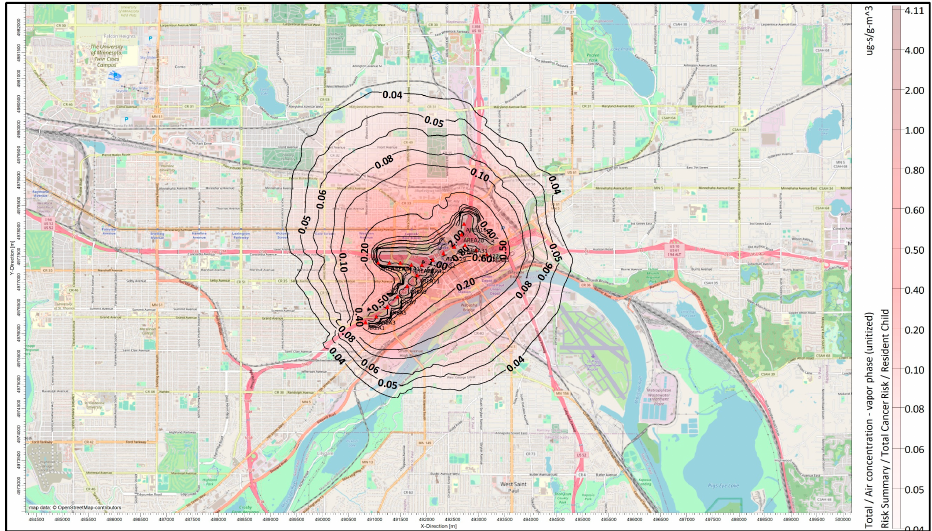
Figure 8. Formaldehyde Annual Air Concentration—Vapor Phase (Unitized) Contour Plot overlaid on OpenStreetMap Satellite Imagery (OpenStreetMap, n.d.). Unit used in contour is µg-s/g-m 3 . A summary of the unitized formaldehyde maximum concentration values and their locations is provided in Table 7.